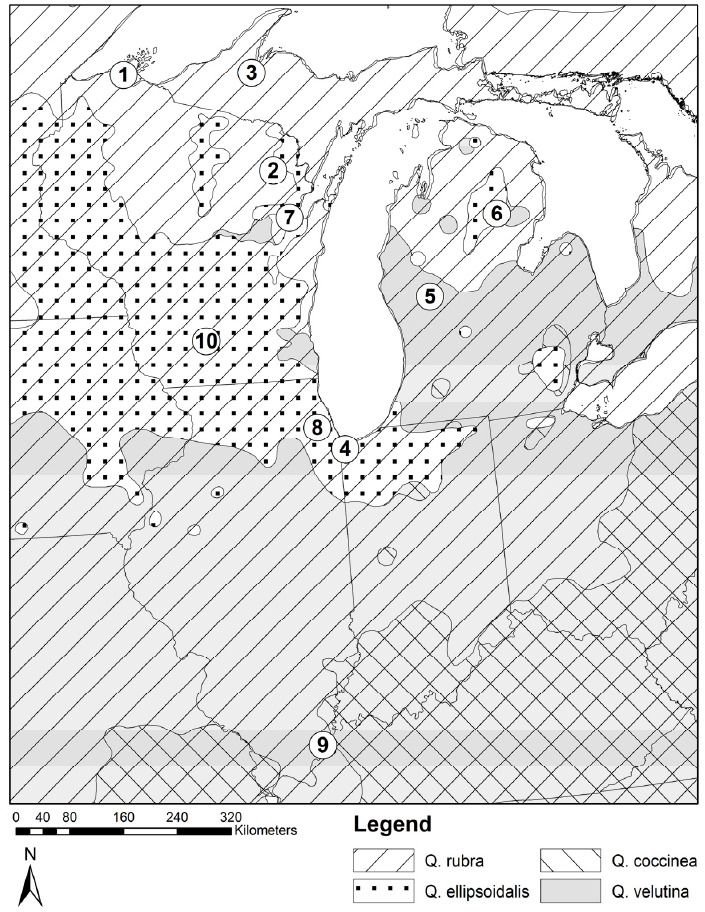
Figure 1. Map of sampled locations; areas 1–2 each include one population pair of Q. ellipsoidalis and Q. rubra , area 3 includes two population pairs of Q. ellipsoidalis and Q. rubra, area 4 includes two mixed Q. ellipsoidalis and Q. velutina populations, areas 5–8 each include one mixed Q. ellipsoidalis and Q. velutina population each, area 9 includes the single Q. coccinea population, and area 10 includes the single sympatric population of Q. rubra/Q. ellipsoidalis/Q. velutina ; area number associated with individual populations is shown in Table S1; approximate species ranges are from Little